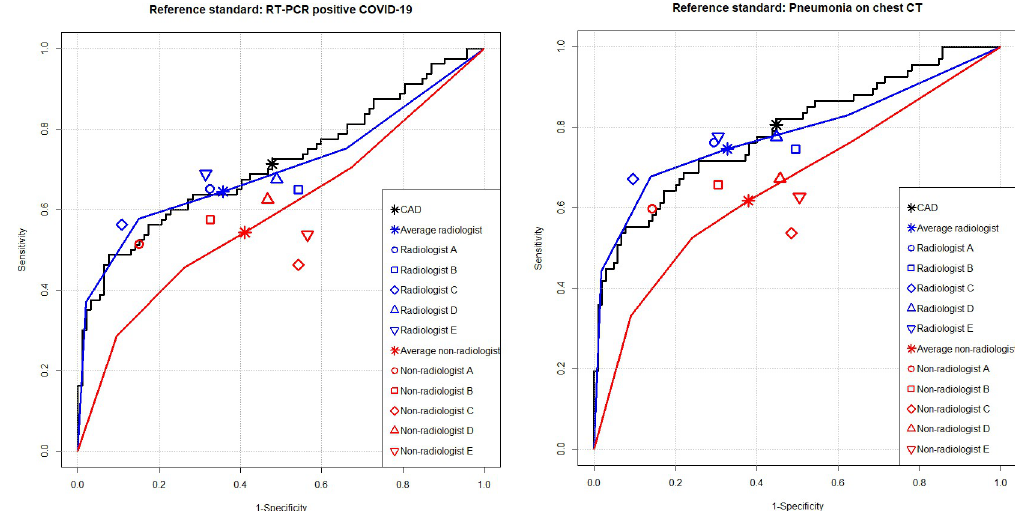
Fig 4. Performance of the CAD versus reader-alone interpretations. For identification of RT-PCR-positive COVID-19 patients ( A ), the CAD exhibited AUC of 0.714 (black line), which did not significantly differ from that of thoracic radiologists (0.701, blue line) but significantly higher than that of non-radiologist physicians (0.584, red line). For identification of pneumonia defined on chest CT ( B ), the CAD exhibited AUC of 0.790 (black line), which was not significantly different from that of thoracic radiologists (0.784, blue line), but significantly higher than that of non-radiologist physicians (0.650, red line).